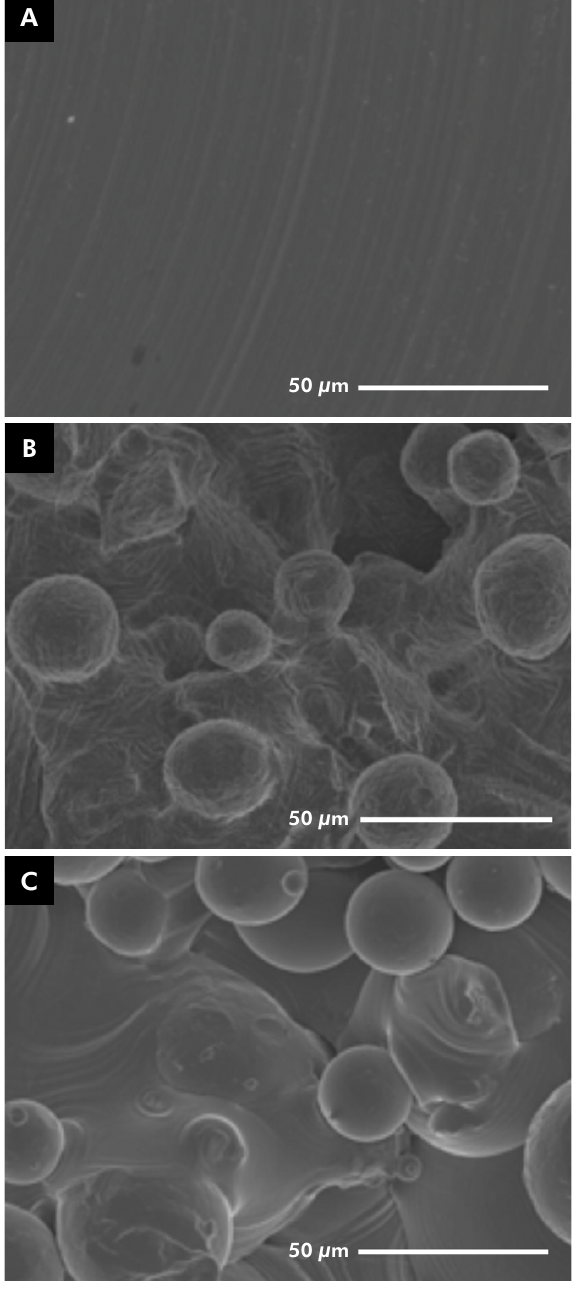
Figure 1. Scanning electronic microscopy of A: G1, discs with machined surface; B: G2, discs produced via the additive manufacturing of titanium with chemical treatment and C: G3, discs produced via the additive manufacturing of titanium without chemical